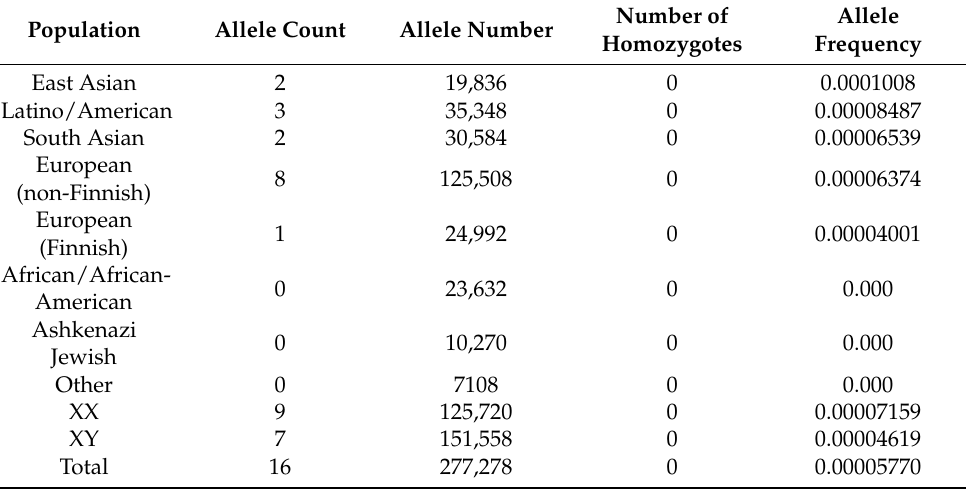
Table 2. Frequency information of the KIF17 p.Arg419Trp variant based on the GnomAD